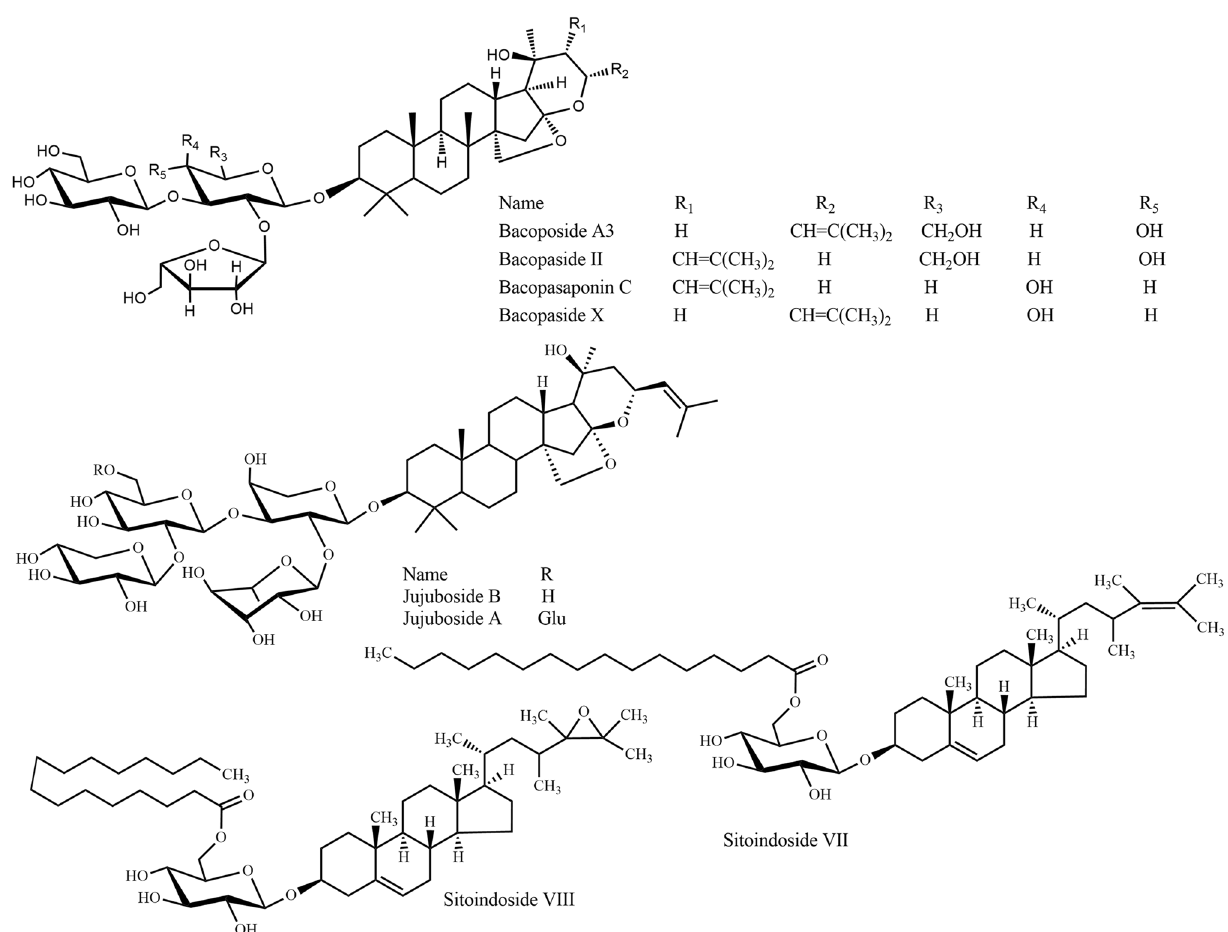
Fig. 9 Triterpenes 2: steroidal